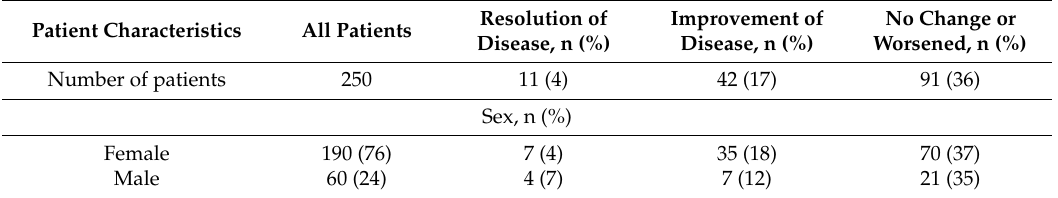
Table 1. Demographics of 250 patients with excoriation disorder